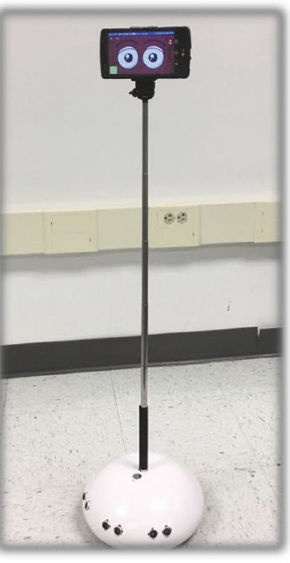
Figure 13: Dali the